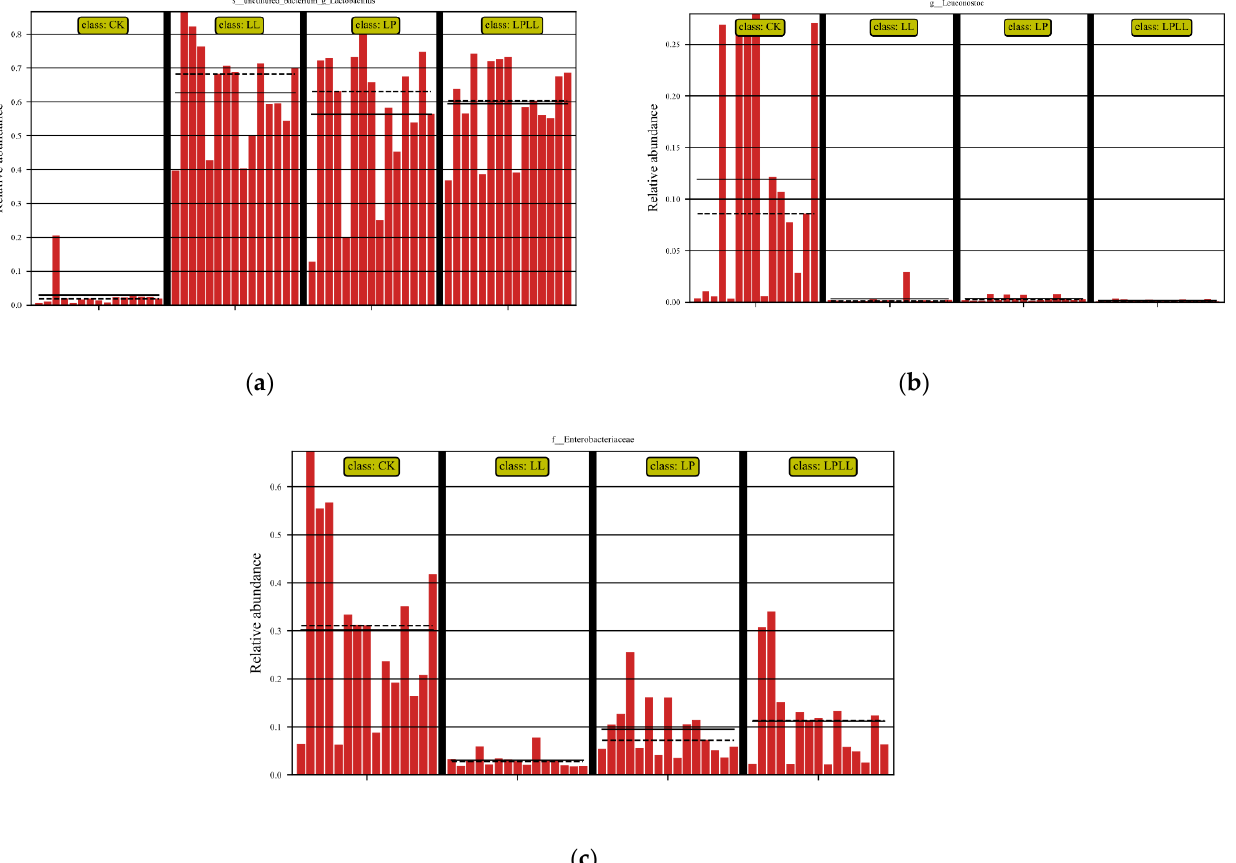
Figure 6. LefSe analysis of fermented sugarcane juice. ( a ): abundance of Lactobacillus . ( b ): abundance of Leuconostoc . ( c ): abundance of Enterobacter . CK: fresh sugarcane juice; LL: sugarcane juice with added HNK10; LP: sugarcane juice added with HNK21; LPLL: sugarcane juice treated with HNK10 + HNK21 was added.